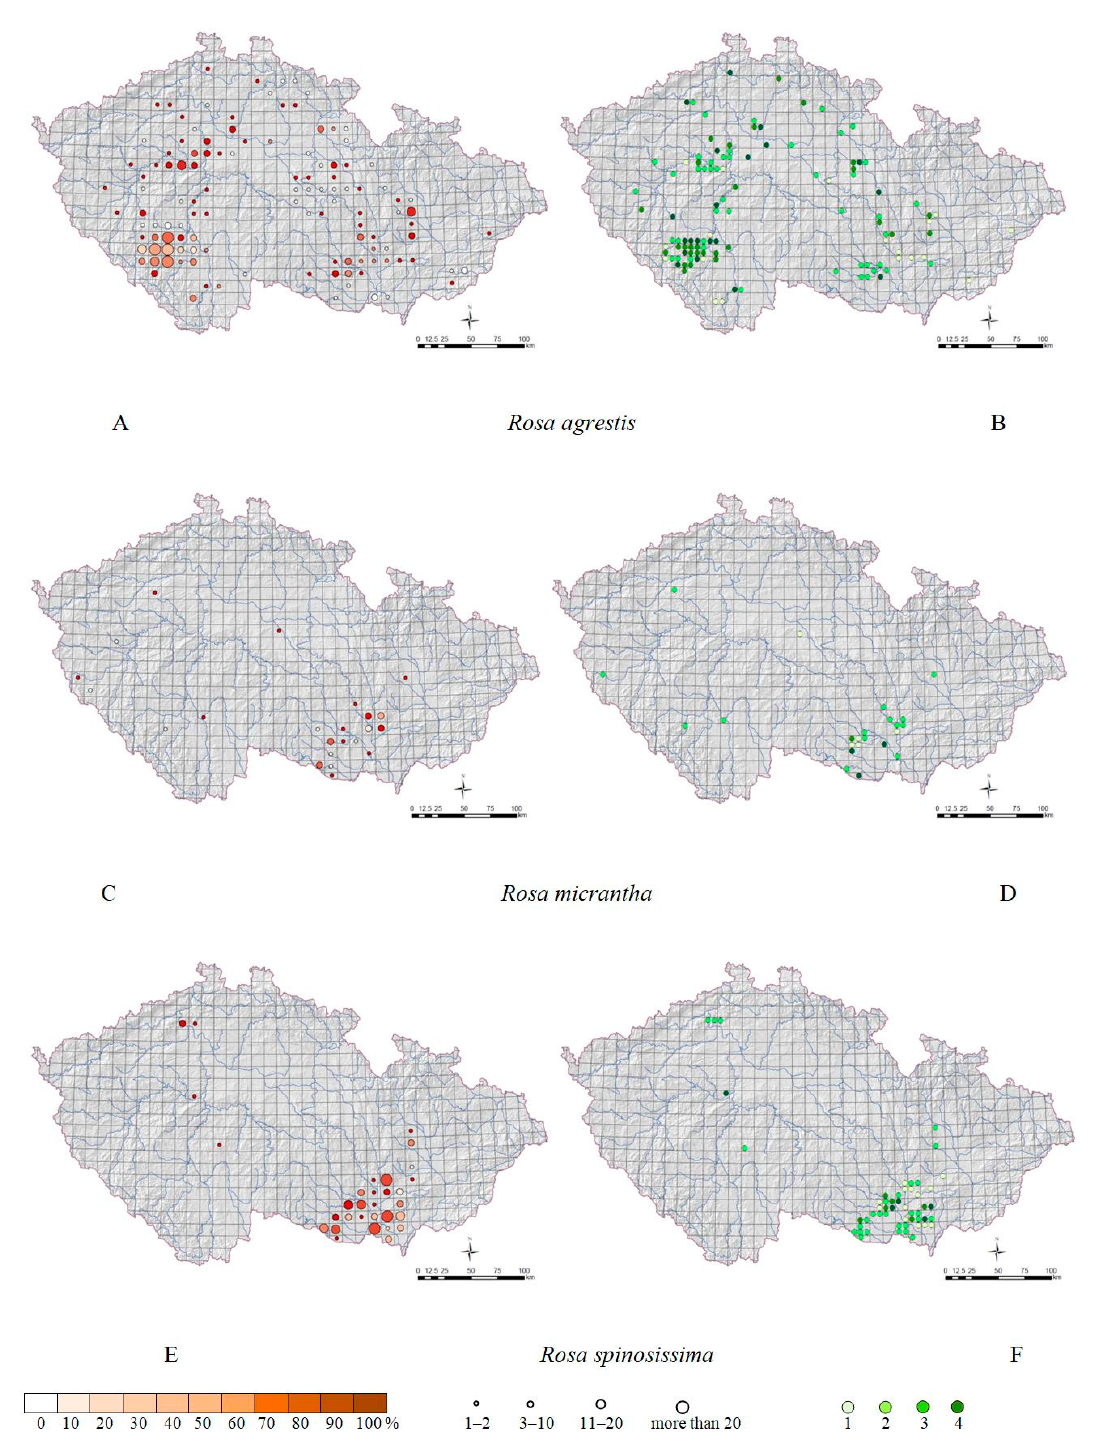
Figure 3. Maps ( A , C , E ): number of occurrences (dot size) and knowledge level of habitat quality (brownish colour); empty circle (0%) = occurrence of the species outside the habitat. Maps ( B , D , F ): habitat quality (1–4); the darker the green colour, the lower the values of quality are. Grid of 10 × 10